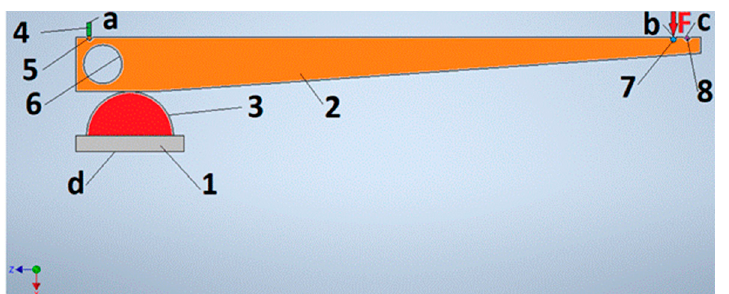
Figure 7. Scheme of numerical model of selected mating components of the measuring unit for determination of the Young modulus of polymer bearing. 1—support fragment, 2—tilt arm, 3—tested bearing material sample, 4—cylindrical tip of the screw with fine thread, 5—bearing needle, 6—surface of tilt arm hole for the needle bearing placement, 7—pin of hoop of a loading unit assembly with weights, 8—bearing needle, a—fixed force of cylindrical tip of a screw, b—cylindrical surface of pin loaded by the force F from weights, c—cylindrical surface of the bearing needle whose displacements along the X-axis are compared with measured values.